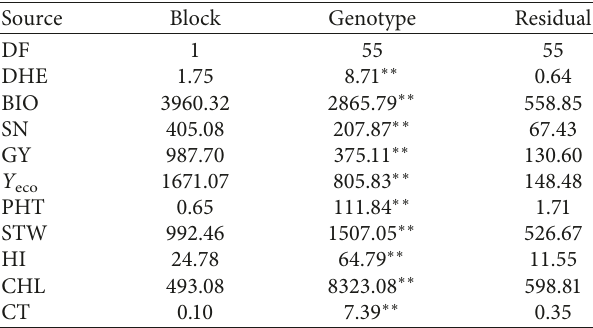
Table 3: Analysis of variance mean squares for 10 characters of 56 durum wheat